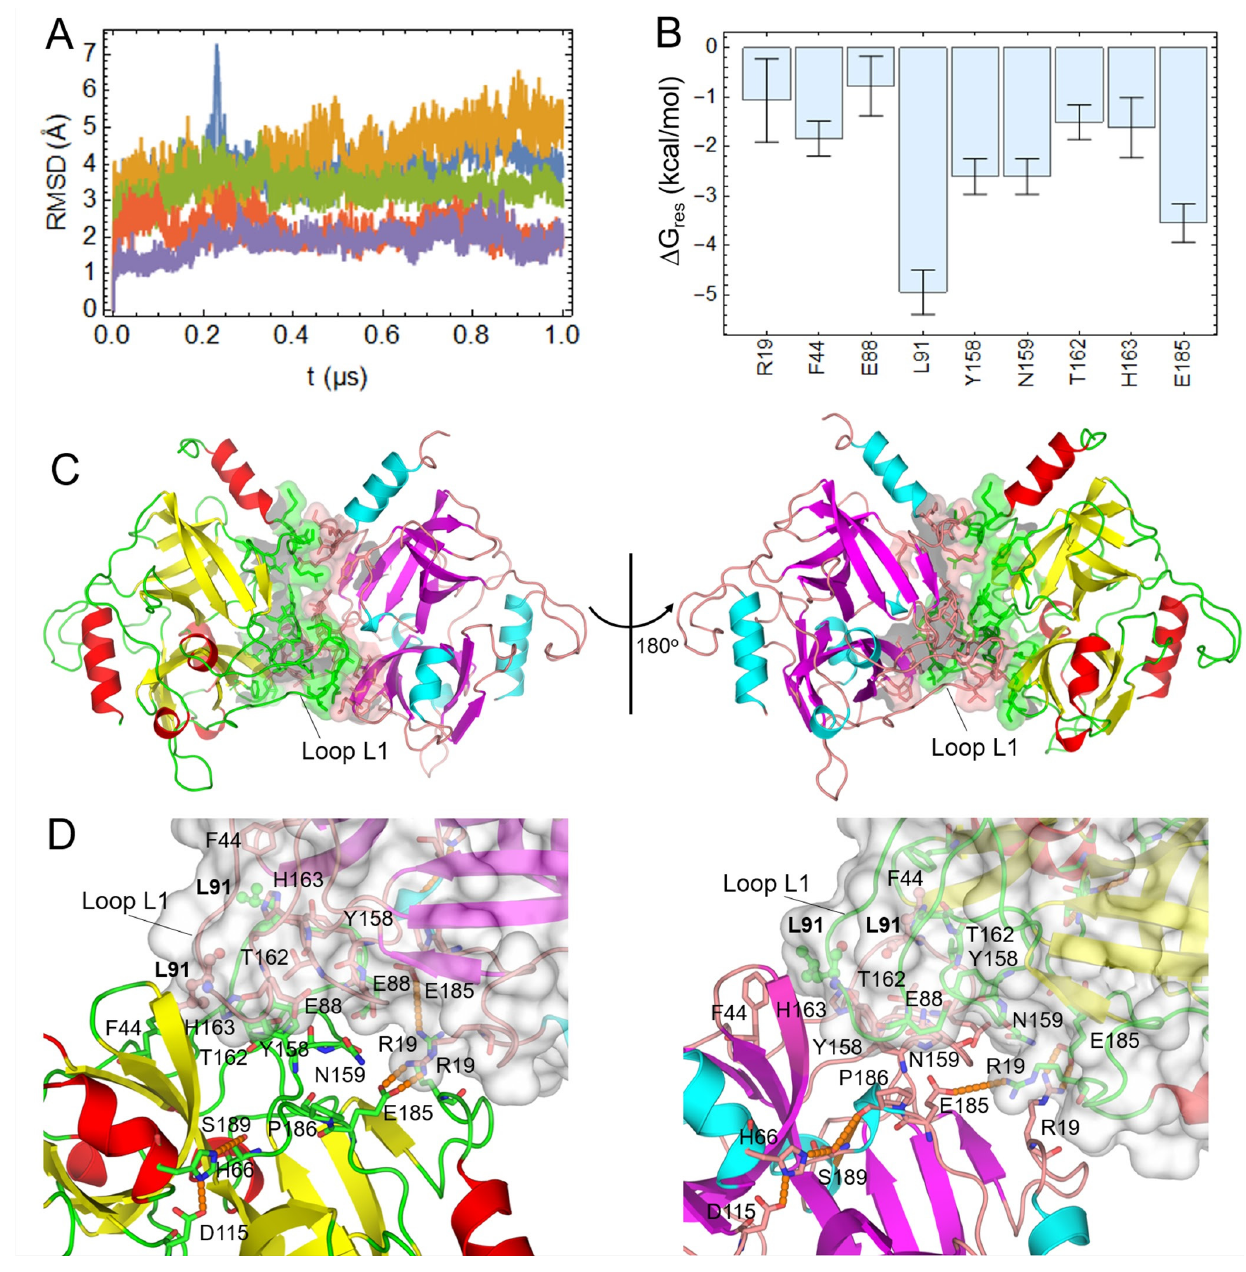
Figure 6. MD-based and structural analyses of the predicted structure of ETE homodimers (ETE 2 -CP-0). ( A ) Backbone root mean squared deviation (RMSD) profiles for the five replicate MD simulations of the ETE homodimer. The initial structure ( t = 0) was taken as reference for the RMSD calculations. ( B ) Per-residue free energies for the main hotspots of the homodimer interface calculated using MM-GBSA. ( C ) Two views of ETE homodimer upon 180° rotation around the vertical axis. The protein structure is represented as cartoons, with secondary structure elements being colored differently, i.e., red/cyan for α -helices, yellow/magenta for β -strands and green/salmon for loops in chains A/B. Interface residues are shown in surface and stick representations. ( D ) Two views of the complex interface displaying interface hotspot and active site residues as sticks. The main hotspot L91 of the homodimer interface is highlighted in sticks and spheres. H-bonds are represented as orange dashed lines.